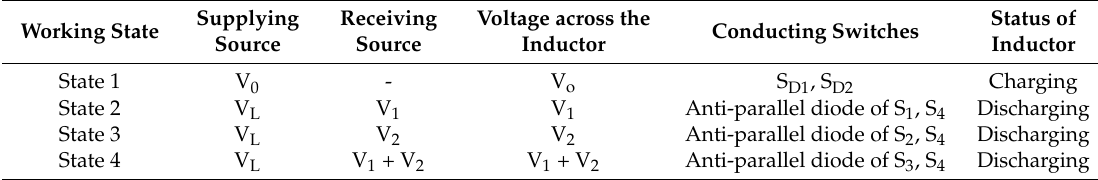
Table 1. Different working states of the MBDC converter (bidirectional operation).